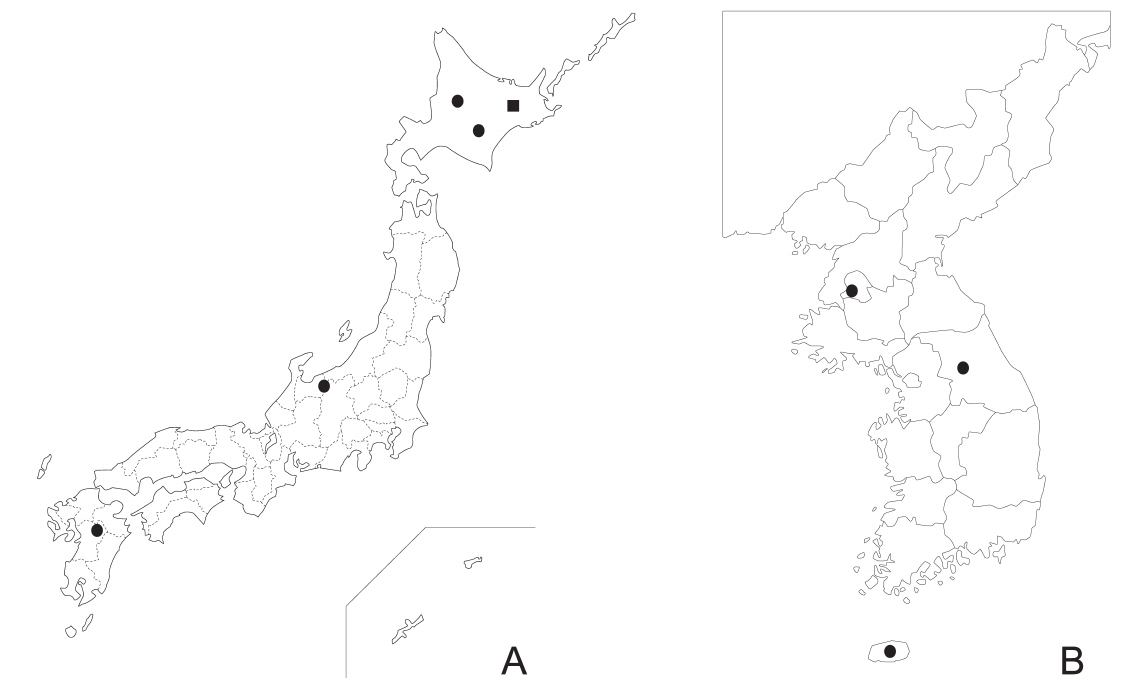
Fig. 3. distribution maps. A . Lasioglossum ( Dialictus ) pseudannulipes (Blüthgen, 1925) and L. ( D.